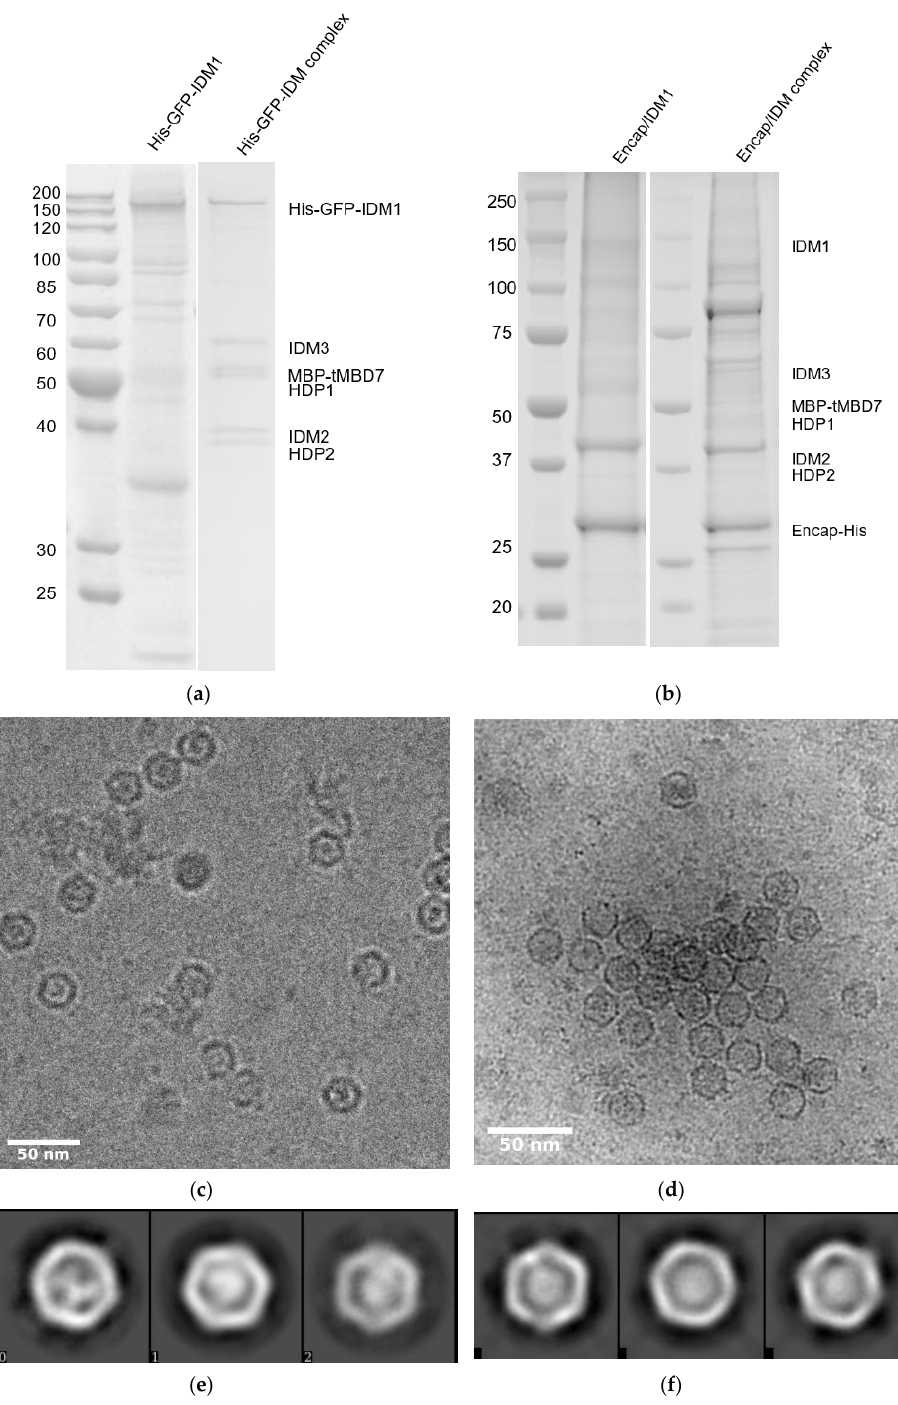
Figure 2. Production of heterologous cargo-loaded encapsulin. The SDS-PAGE result of His-GFP-IDM1 and His-GFP-IDM complex ( a ), Encap/IDM1 and Encap/IDM complex ( b ). His-GFP-IDM1: His-GFP fused at the N-terminal of IDM1. The IDM complex without encapsulin ( a ) was purified with the His-tag on the N terminal of IDM1 protein. In the Encap/IDM complex, there was no His-tag on IDM1 but was at the C-terminal of encapsulin capsid (Encap). The molecular weight of His-GFP tag, MBP tag, IDM1, IDM2, IDM3, HDP1, HDP2, and MBD7 are 32kDa, 40kDa, 131kDa, 39kDa, 52kDa, 46kDa, 33kDa, and 35kDa, respectively. Cryo-EM image of Encap/IDM1 ( c ) from Talos F200X G2 and Encap/IDM complex ( d ) from Titan Krios. Representative 2D class averages generated from the Encap/IDM1 ( e ) and the Encap/IDM complex dataset ( f ). The “matchto” processor in EMAN2 [27] accessed through e2proc2d.py was used to filter the 2D class averages to the same level by matching their structure factor curves.